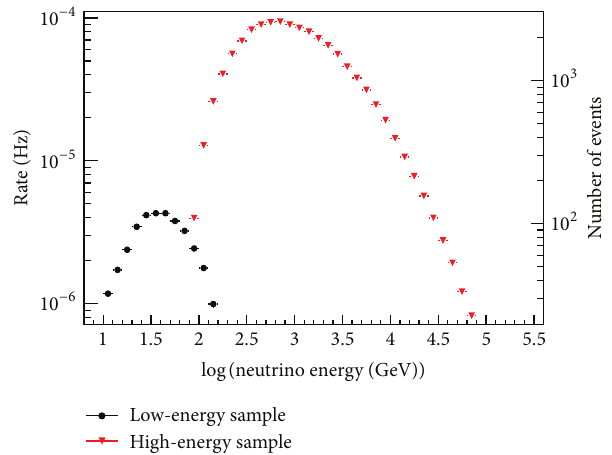
Figure 2: Expected distribution of the neutrino energy of atmo- spheric neutrinos in the low-energy (DeepCore) and in the high- energy (IceCube) samples according to simulations (figure from